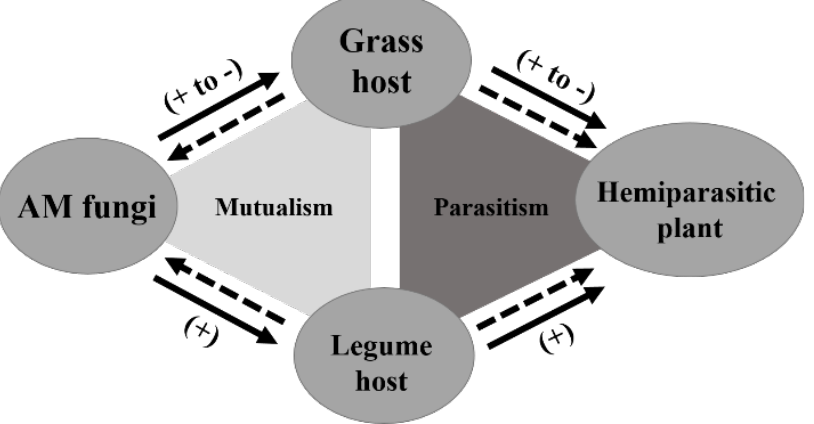
Figure 6. Simple model of interaction among AM fungi, grass host, legume host, and hemiparasitic plant. The arrow direction indicates the direction of nutrient flow. Solid arrows represent mineral nutrient flow, and dashed arrows indicate carbon flow. The plus and minus in parentheses represent directly positive or negative effects of AM fungi on the growth of different host plants and the indirect effect of AM fungi on the growth of hemiparasites attached to grass or legume hosts.